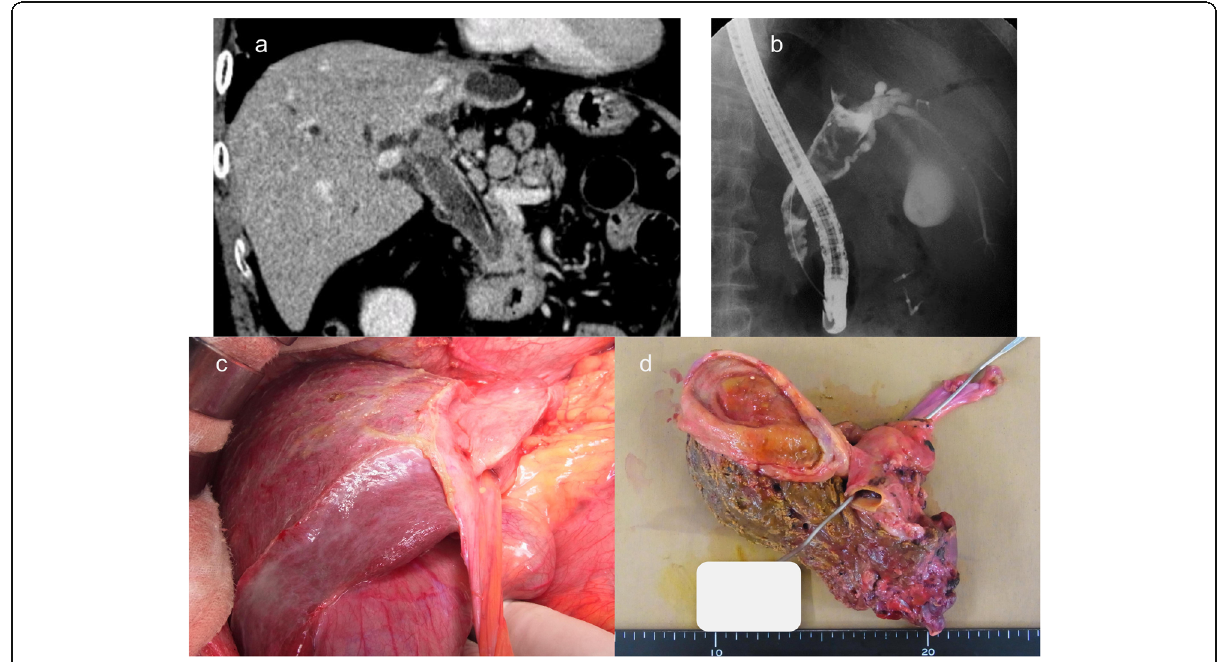
Fig. 1 Contrast-enhanced computed tomography (CT) and endoscopic retrograde cholangiopancreatography (ERCP). a CT shows dilation of the intrahepatic and extrahepatic bile ducts, wall thickening of the common bile duct, and atrophy of the left liver lobe. b ERCP demonstrates a defect in the left intrahepatic and common bile ducts. Furthermore, a mass in the common bile duct is indicated. c Intraoperative findings showed atrophy of the left lobe. d Left hepatectomy, caudate lobectomy, and extrahepatic bile duct resection were